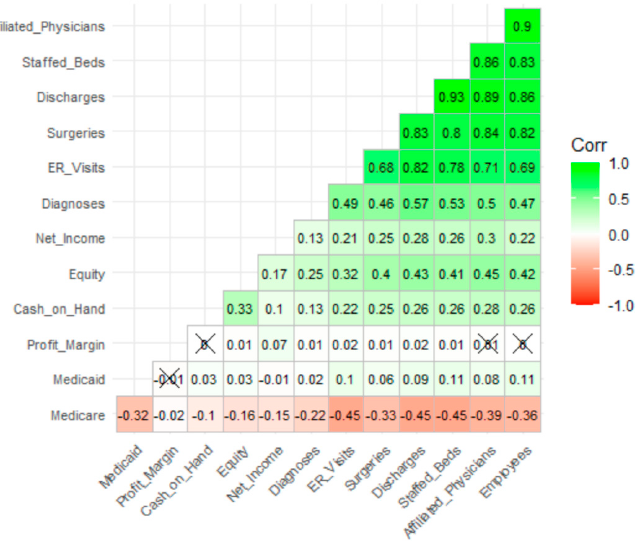
Figure 6. Hierarchical clustered correlation of quantitative variables.